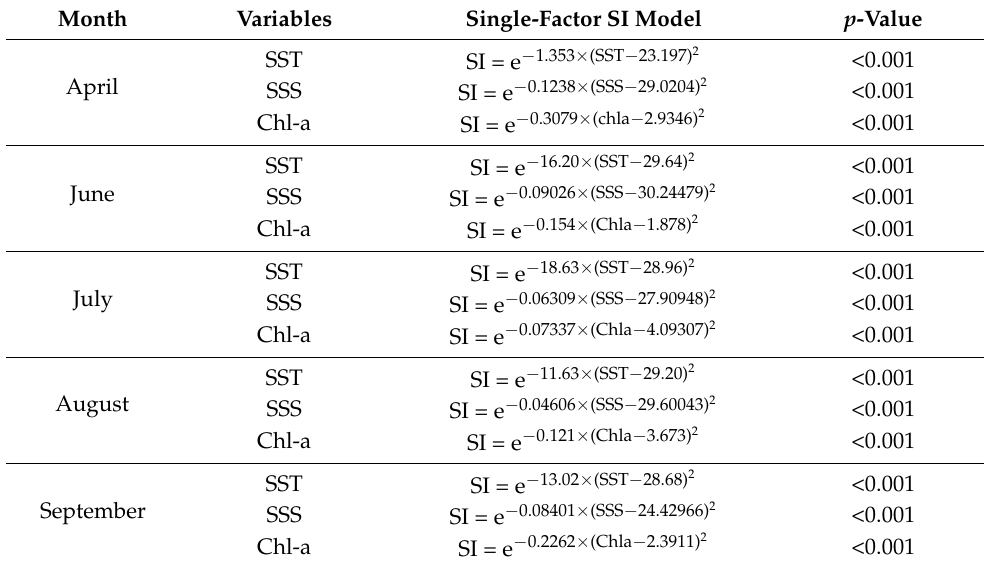
Table 1. SI model for each environmental factor of larvae in the